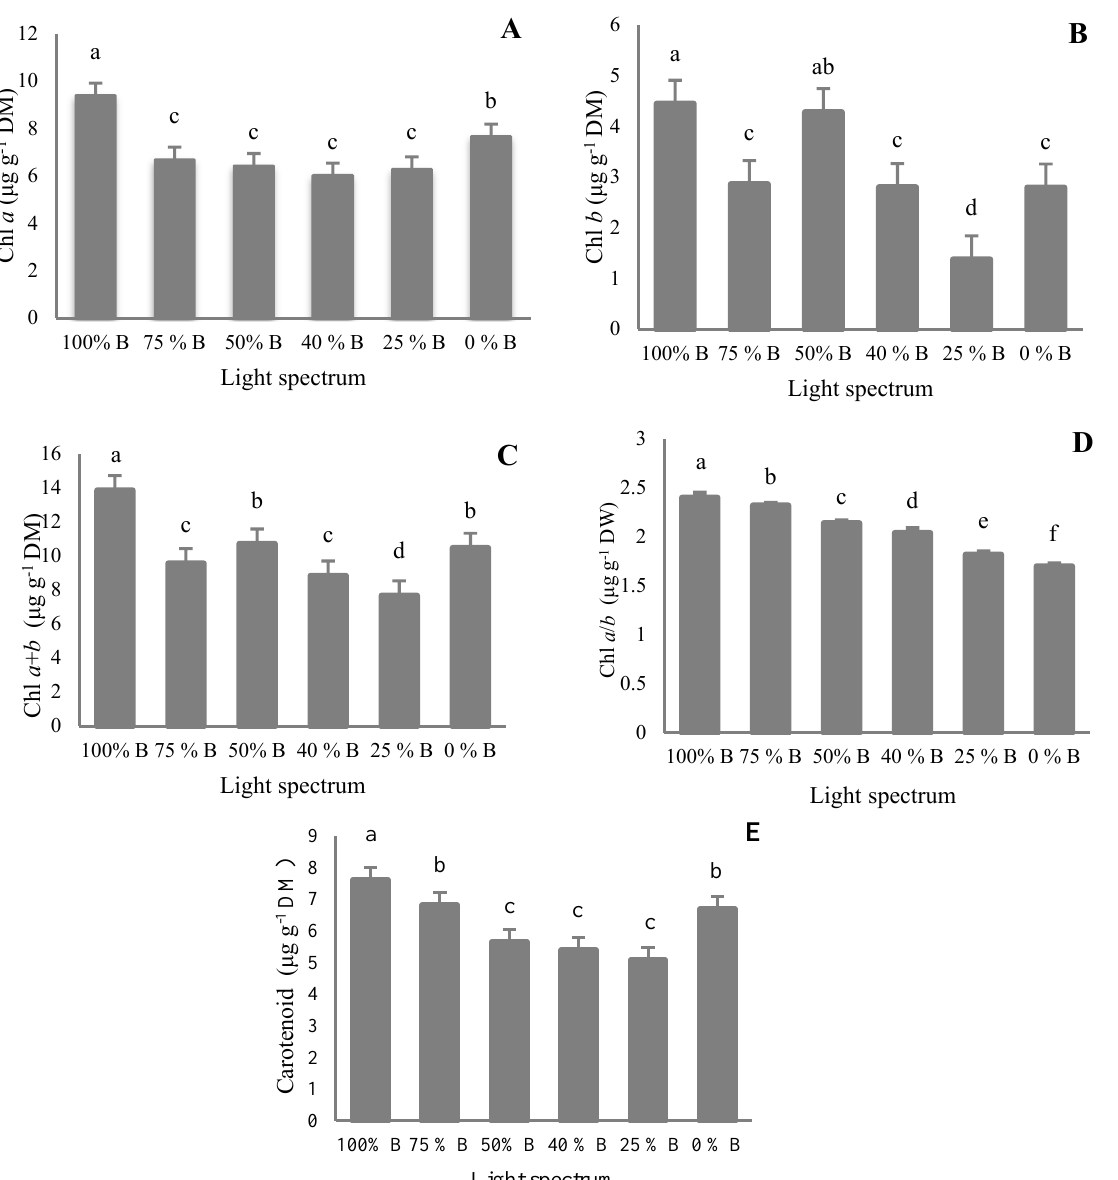
Figure 8. Chlorophyll a ( A ; Chl a ), Chlorophyll b ( B ; Chl b ), total chlorophyll ( C ; Chl a + b ), chlorophyll a / b ratio ( D ; Chl a / b ) and carotenoid ( E ) accumulation of saffron plants grown under different ratios of Blue (B) to Red (R) light in the overall spectral composition including 100% B, 75% B, 50% B, 40% B, 25% B, 0% B (see the spectrum in Figure 1), with 150 ± 10 µ mol m − 2 s − 1 PPFD. Different letters indicate that values are significantly different at p < 0.01 according to Duncan’s multiple range tests. Bars represent mean value ± standard deviation .